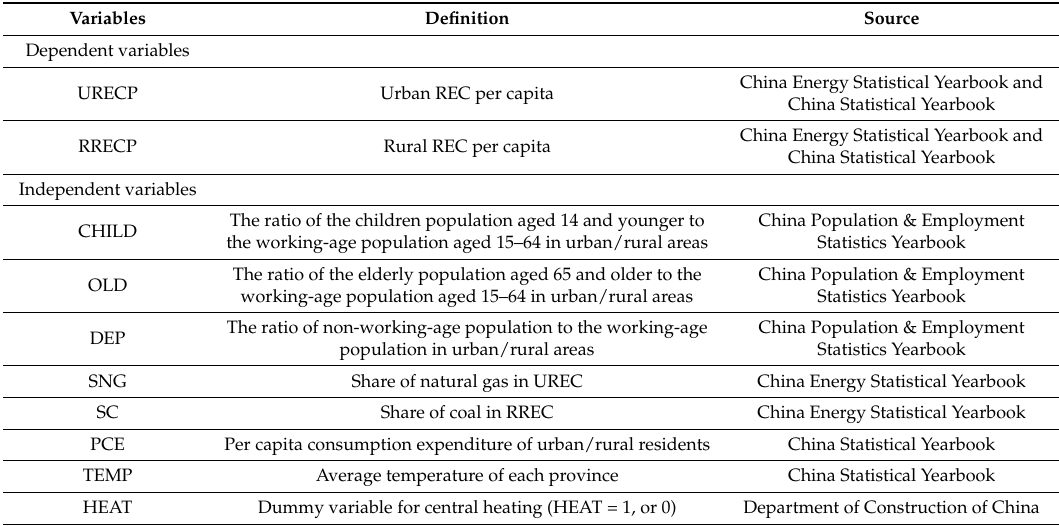
Table 2. Summary of variables in this